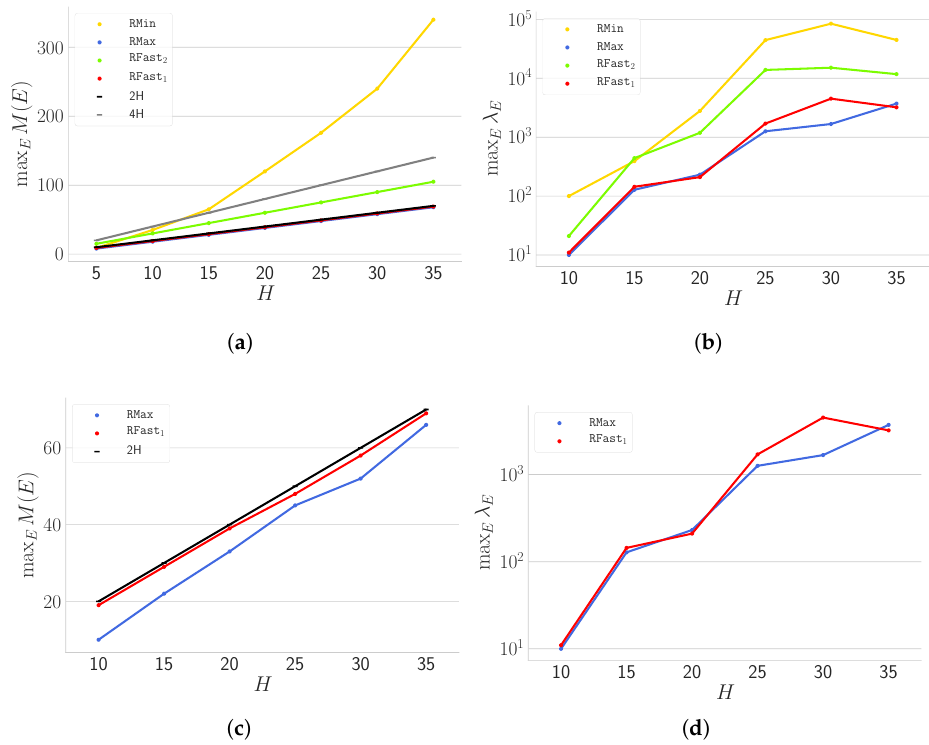
Figure 7. How maximum M ( E ) ( a , c ) and maximum λ E ( b , d ) change as a function of H when instances are induced by all partitions of H ∈ { 10,15,20,25,30,35 } having cardinality n = 10. Panels ( c , d ) show strategies that, experimentally, exhibit